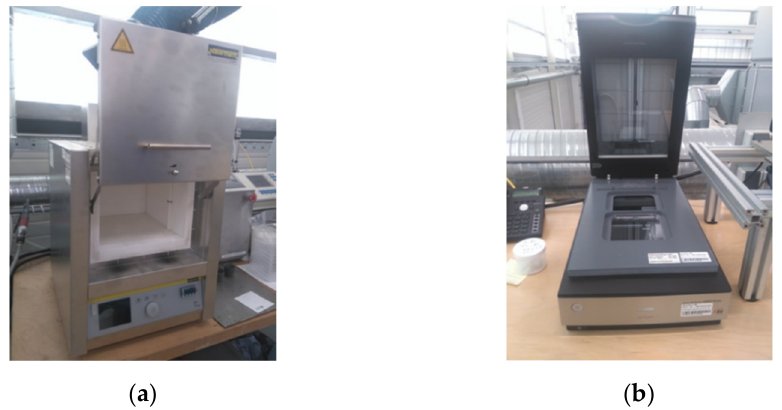
Figure 3. Experimental equipment used for fiber length analysis of the PP/GF30 short fiber-reinforced thermoplastic composite: ( a ) electric furnace and ( b ) photo